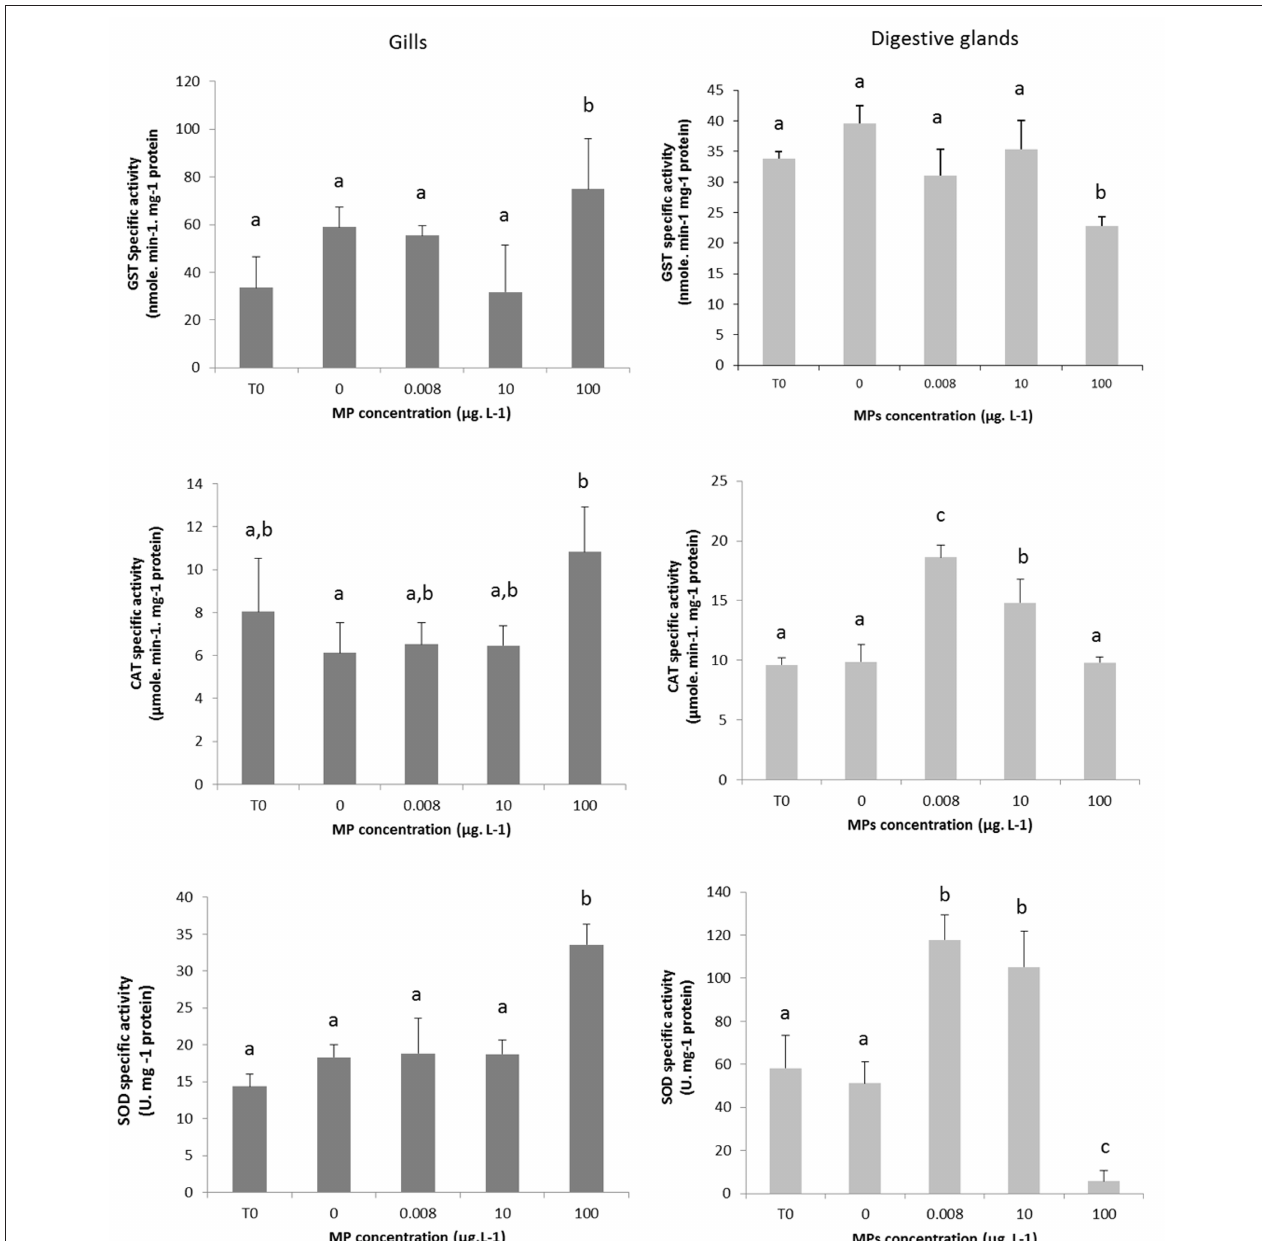
FIGURE 2 | Enzymatic activity of GST, SOD, and CAT in gills and digestive gland of mussels Mytilus spp. at T0 and after 10 days in control mussels (0 MPs L − 1 ) and in mussels exposed to PE and PP microplastics at 0.008, 10, and 100 µ g MPs L − 1 (mean + SD, N = 3). Different lower-case letters indicate significant differences between control and microplastic exposed treatment ( p <